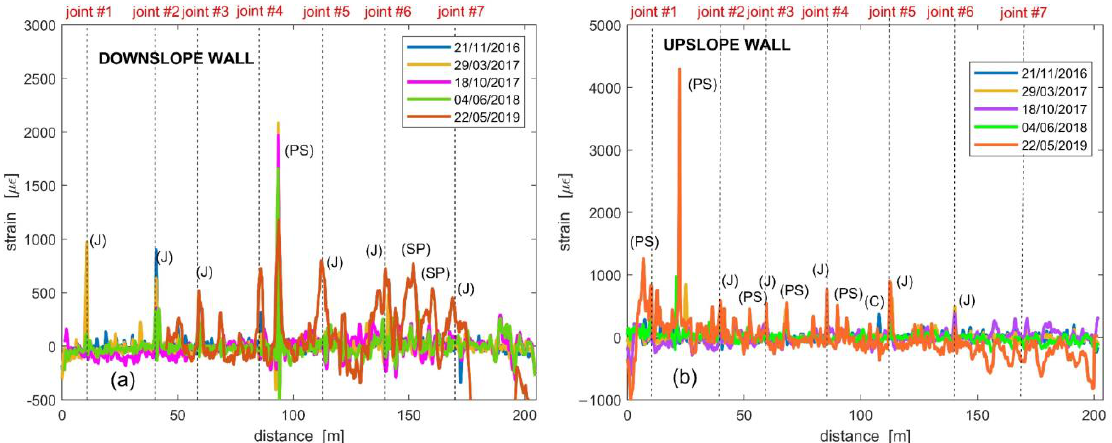
Figure 10. Results of the optical fiber strain measurement along the downslope ( a ) and upslope ( b ) tunnel wall, with indication of the position of joints. J — Joint, PS — local Parget Swelling, SP — Salt tunnel wall, with indication of the position of joints. J—Joint, PS—local Parget Swelling, SP—Salt Precipitate accumulation, C — Crack (from Ref. [66]). Precipitate accumulation, C—Crack (from Ref.